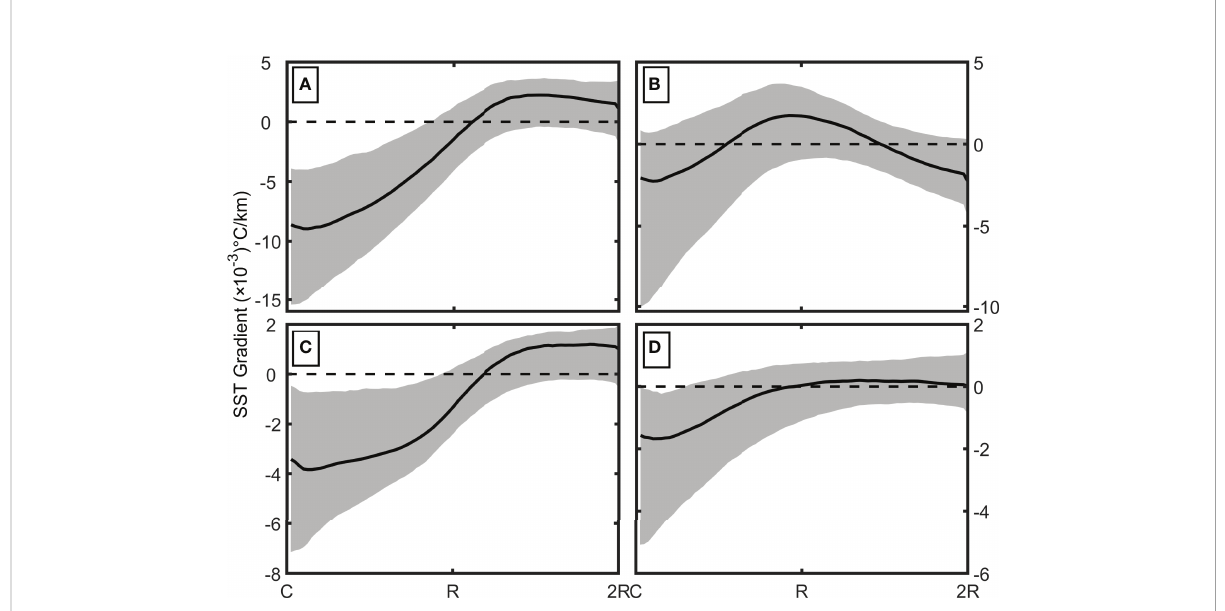
FIGURE 6 Averaged monopole of the SST gradient (×10 -3 °C/km) over different distances from the eddy center for (A) an anticyclone and (B) a cyclone in the north and for (C) an anticyclone and (D) a cyclone in the south. The horizontal dotted line represents the value of zero. The distance labeled on the x-axis shows the center C, radius (R) and twice the radii (2R) of the composited eddies. The gray shading represents the range between 30% and 70% of the total